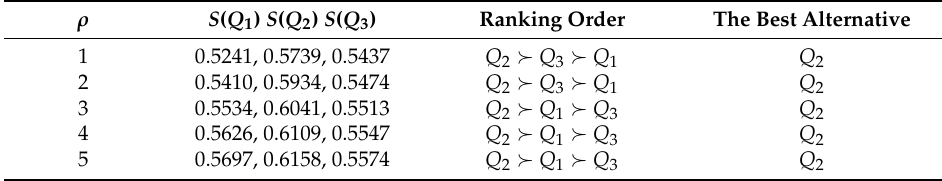
Table 3. Ranking results of the NCDWAA operator for different operational parameters.